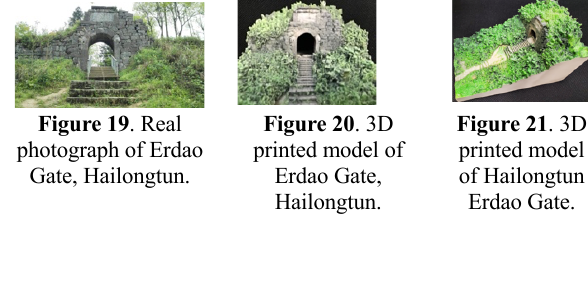
Figure 19 . Real photograph of Erdao Gate, Hailongtun.